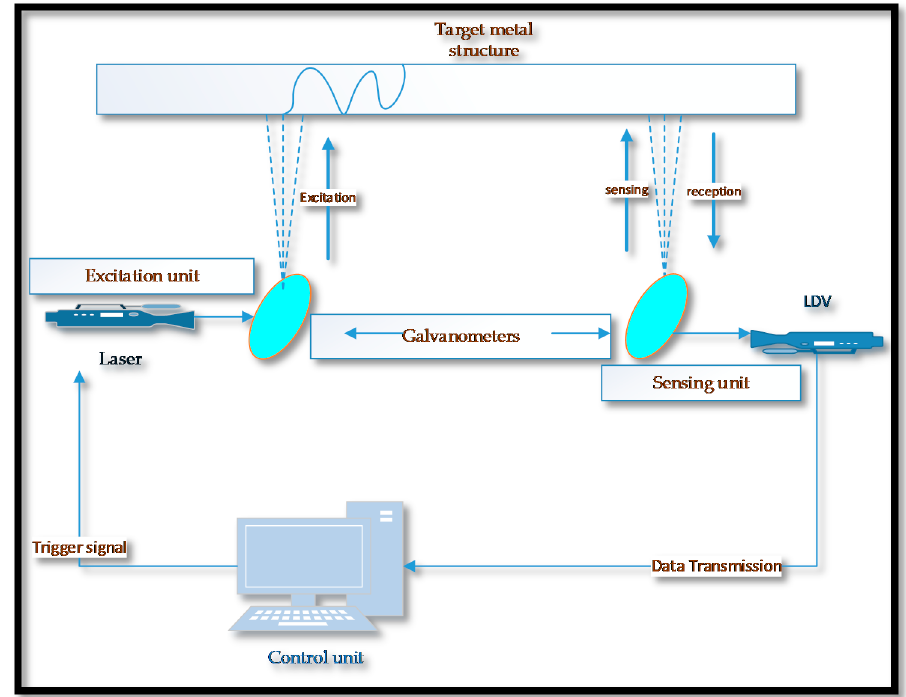
Figure 9. A fully non-contact laser ultrasonic scanning system.